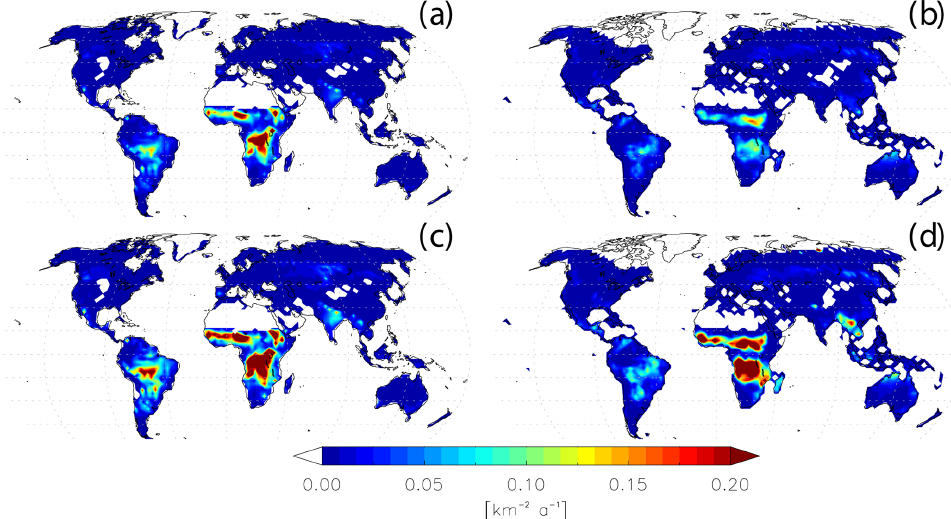
Figure 7. Annual mean model (a, c) and MODIS (b, d) active fires. Modeled annual mean is based on an ensemble of 10 simulations. Simulated fires sampled at the daytime Terra overpass time, 10:30LT (a) , and daytime Aqua overpass time, 13:30LT (c) . MODIS active fires are based on MODIS Terra (b) and MODIS Aqua (d) from 2003 to